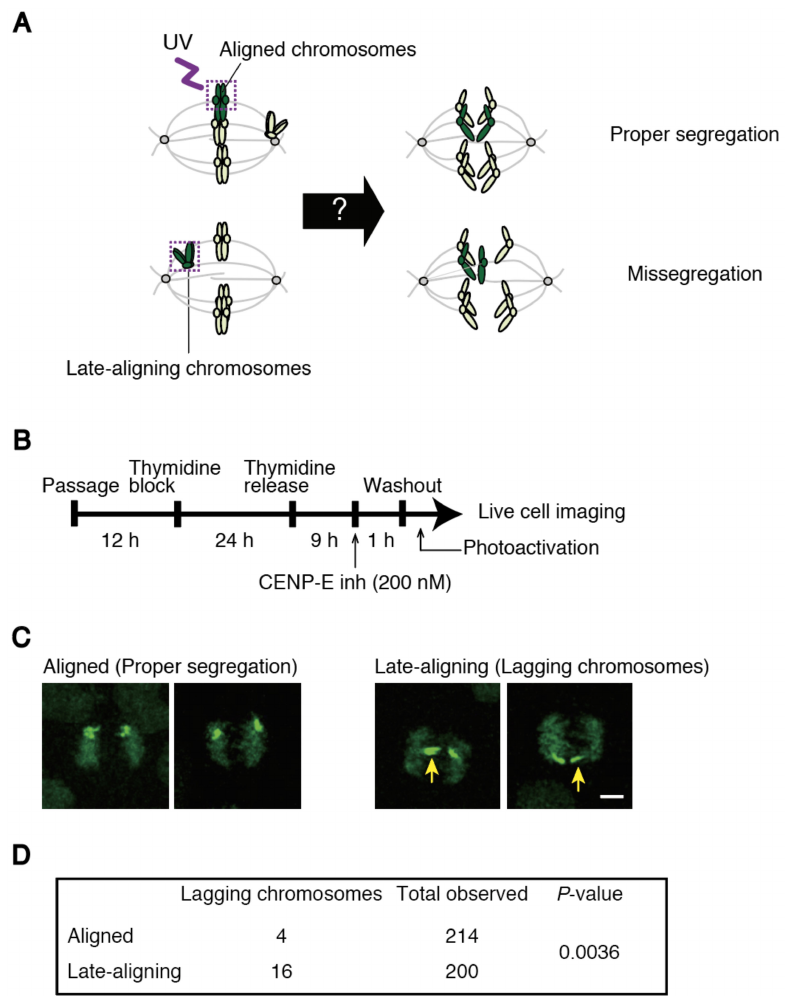
Figure 5. Late-aligning chromosomes are preferentially missegregated. ( A ) Schematic of experiment to track late-aligning chromosomes by photoactivation-based labeling; ( B ) experimental procedure to photoactivate chromosomes after washout of a CENP-E inhibitor; ( C ) examples of tracking of photoactivated chromosomes. Photoactivated aligned chromosomes that segregated properly (left), or late-aligning chromosomes that gave rise to lagging chromosomes (right) are shown. Lagging chromosomes are indicated by yellow arrows. Scale bar: 5 µ m; ( D ) incidence of lagging chromosomes for aligned or late-aligning chromosomes. P -value was obtained using Chi-squared